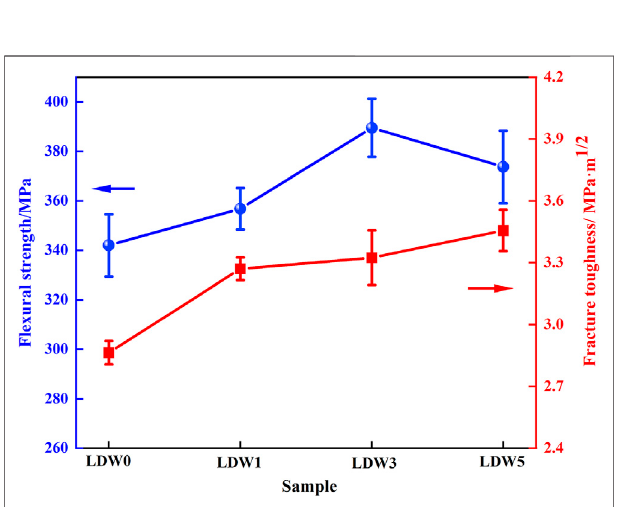
Frontiers in Materials |